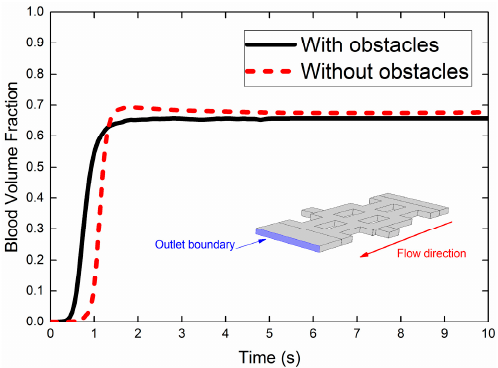
Figure 15. Average blood volume fractions scored over the outlet boundary of the nozzle (shown in blue) for mixing chambers with and without obstacles. blue) for mixing chambers with and without obstacles.